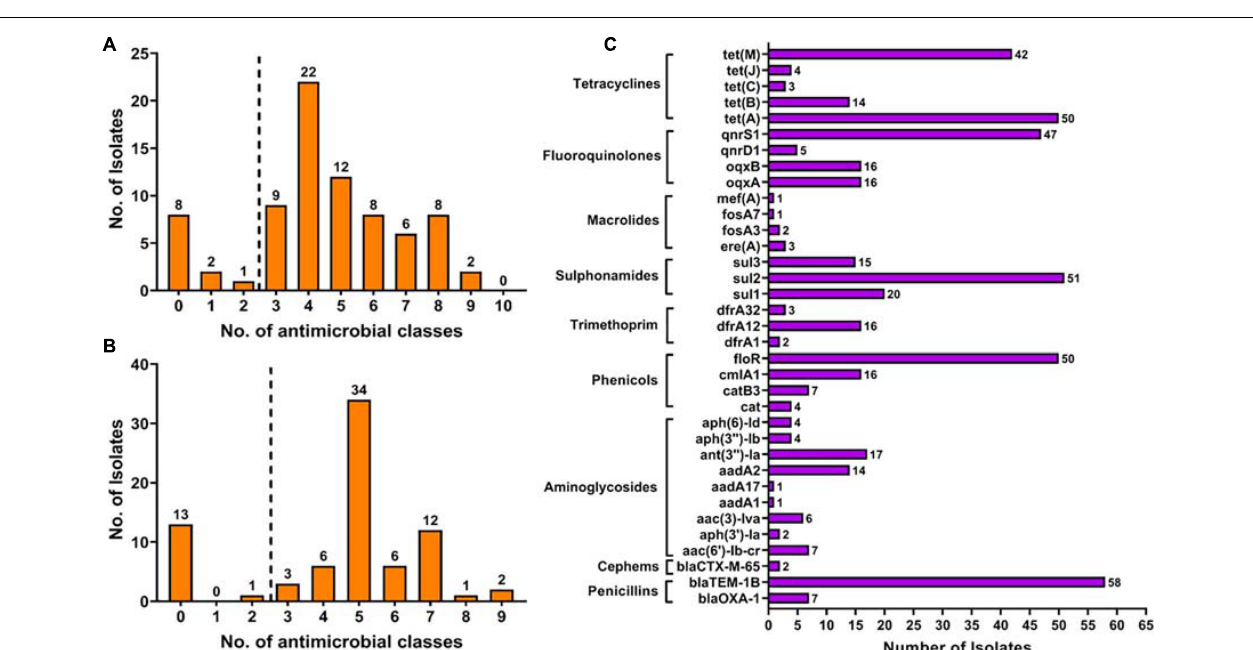
FIGURE 1 | The distribution of multiple drug resistance isolates according to the results obtained by phenotypical (A) and genotypical (B) tests. The detection of antimicrobial resistance genes (C) showed the high prevalence of resistance gene encoding resistance to penicillins, phenicols, sulfonamides, fluoroquinolones, and